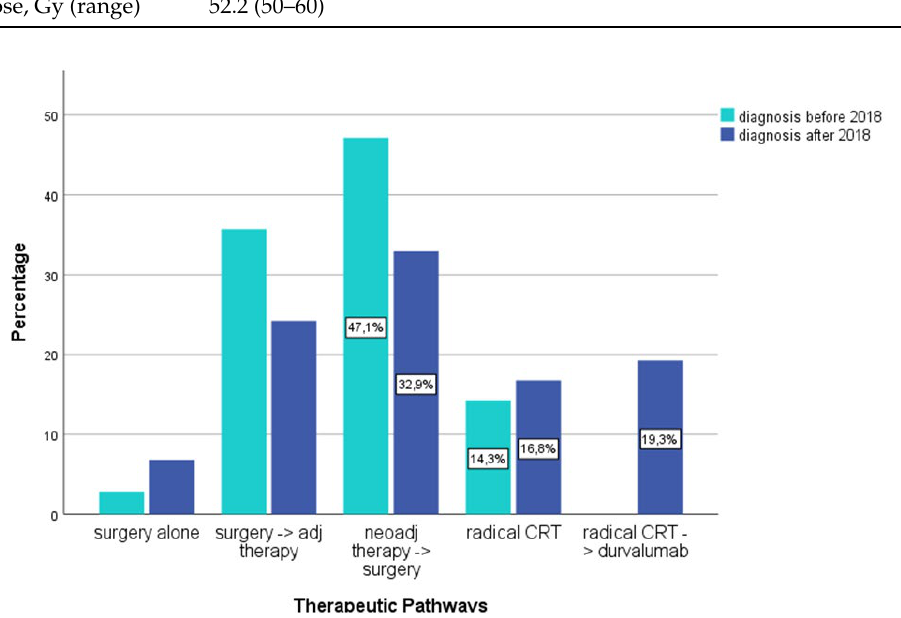
Figure 2. Bar graphs of therapeutic pathways before and after 2018. CRT, chemo-radiation therapy. In the intention to treat (ITT) population, 122 patients underwent neoadjuvant therapy and the radiologic evaluation at the end of the induction treatment revealed the following data: 65 patients (53.3%) had a partial response (PR), 1 (0.8%) had a complete radiological response (CR), 51 (41.8%) reached a stable disease (SD), and 4 (3.3%) had progressive disease